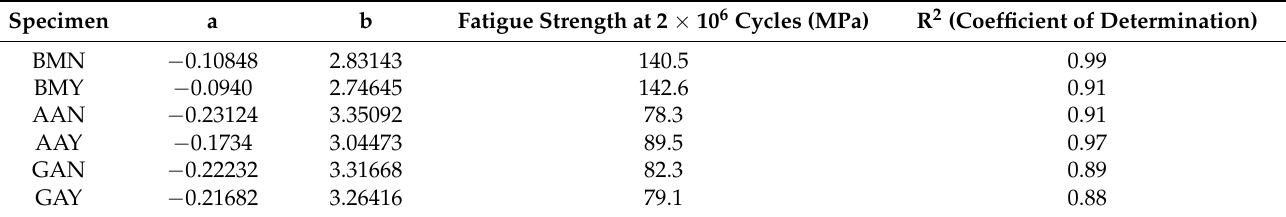
Figure 19. Comparison of S-N curves. ( a ) Comparison between BMN and BMY; ( b ) comparison between AAN and AAY; ( c ) comparison between GAN and GAY; ( d ) comparison between AAN and GAN; and ( e ) comparison between AAY and GAY. Table 5. Parameter values of the S-N curves (Log ∆ σ = a Log N +